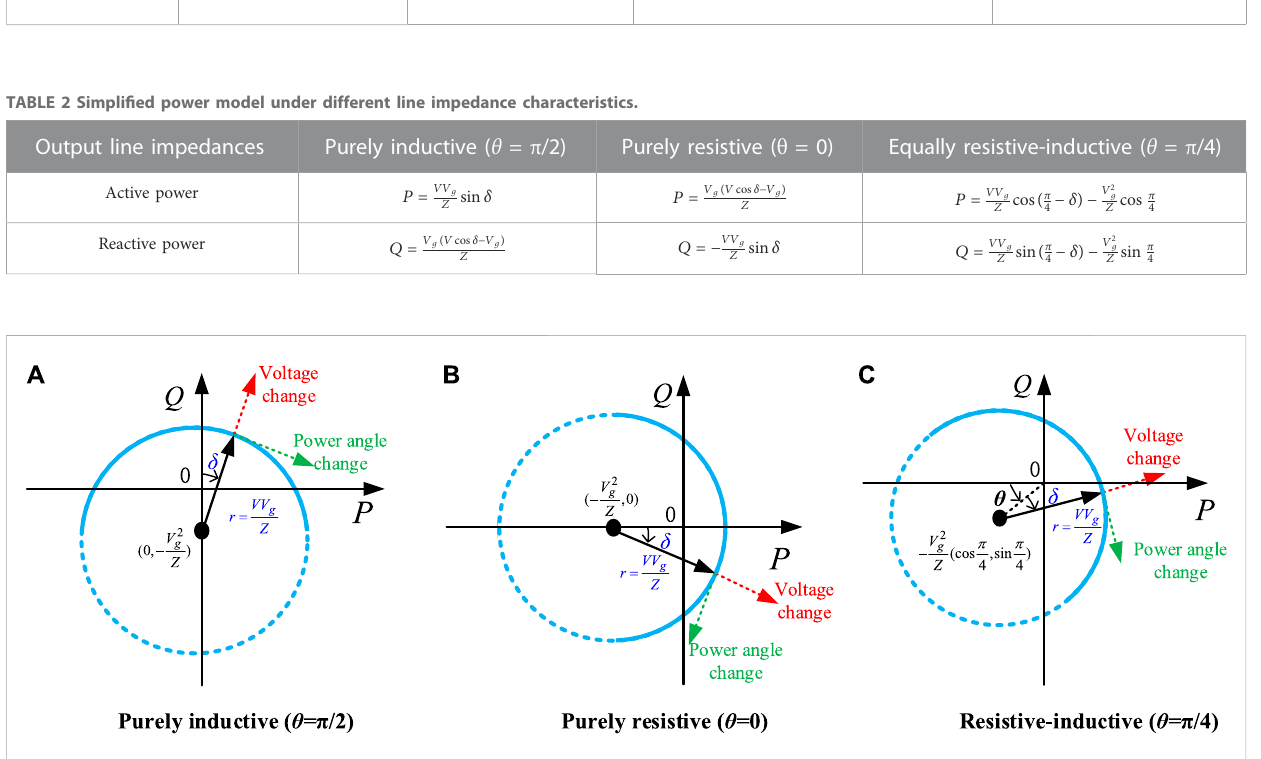
FIGURE 3 Diagram of power circle unit under different line impedance characteristics. (A) Purely inductive line; (B) purely resistive line; (C) Equally resistive- inductive